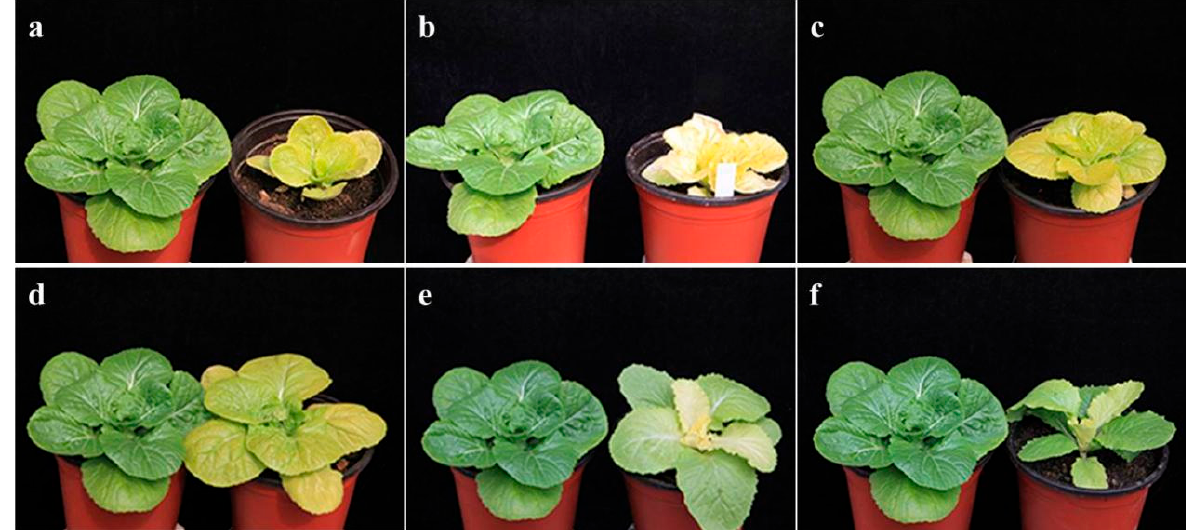
Figure 6. Six leaf color mutants. ( a – c ) The wild-type ‘FT’ plants (left) and complete leaf etiolation mutants (right); ( d – f ) the wild-type ‘FT’ plants (left) and partial leaf etiolation mutants (right). A total of 250 leaf shape mutants were obtained in the M 2 generation. The mutation frequency was 6.7%. The mutations included changes in leaf margin (Figure 7a,b right), mesophyll (Figure 7c right), and crimp degree (Figure 7d–f right). The no mesophyll mutants were rare, and their leaves were twisted into strips (Figure 7c right). The leafy head of wild-type ‘FT’ was ovoid, and the heading leaves were folded and shriveled. A total of 85 leafy head mutants were verified in the M 2 generation, and the mutation frequency was 2.27%. Forty-six non-heading mutants were identified (Figure 8). Twenty vertical leafy head mutants were observed at a frequency of 0.54%. A total of 16 early-bolting mutants were observed (Figure 9 right), and the flowering time was about 25 days earlier than the wild-type ‘FT’